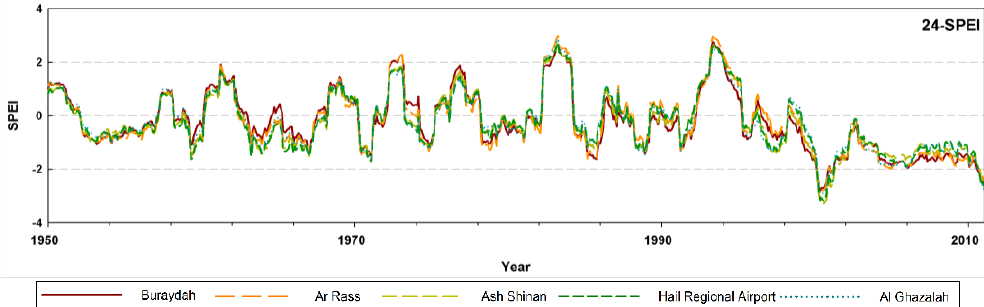
Figure 2. Standardized Precipitation Evapotranspiration Index (SPEI) series at different time scales for Al-Qassim and Hail regions during 1950–2011.